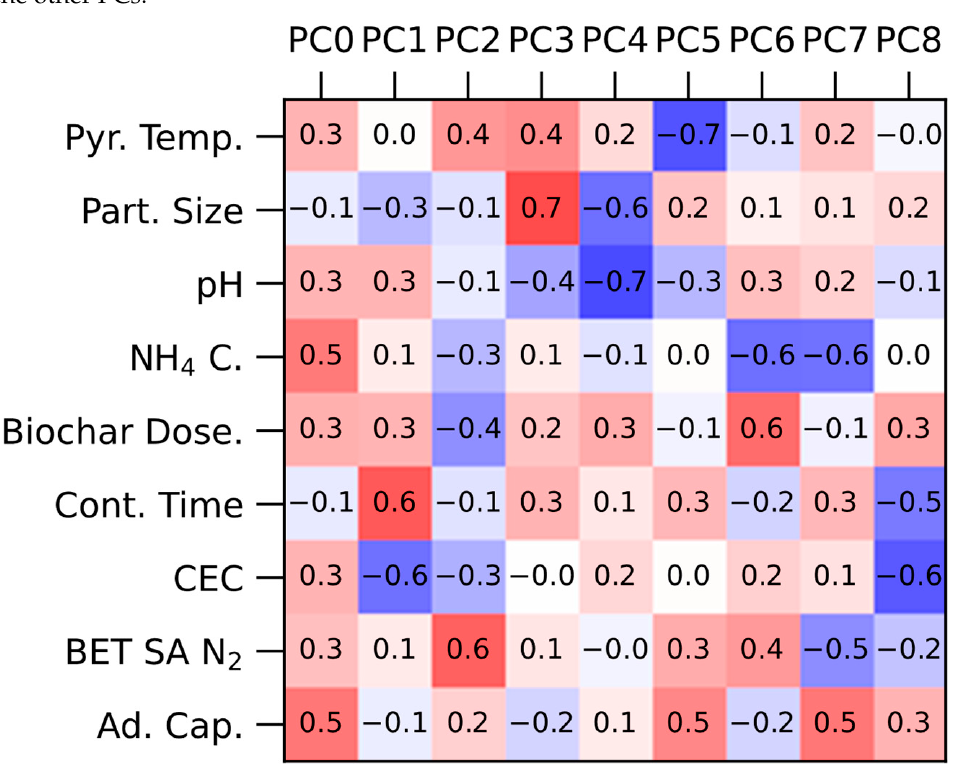
Figure 4. PCA loading matrix for all data.